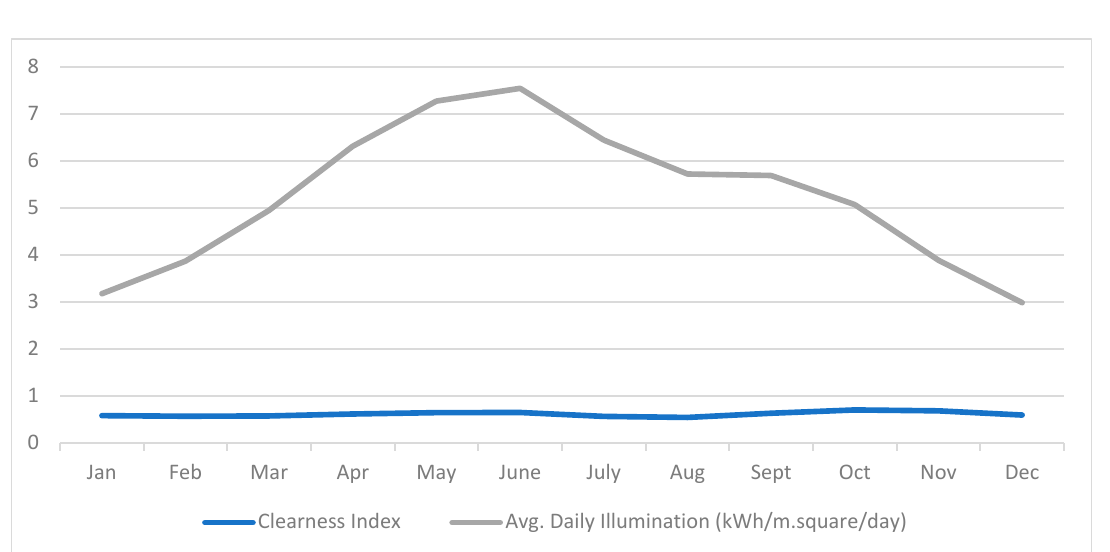
Figure 2. Metrological data of the site. prediction of the worldwide energy resources power database. The value of temperature was the average of a 30-year period. The data shows that the annual average temperature was 18.05 °C. Figure 3 indicates the temperature variation for selected site throughout the year, in January the temperature is at a minimum value of 6.940 °C, and in June, the temperature is at a maximum value of 27.600 °C.